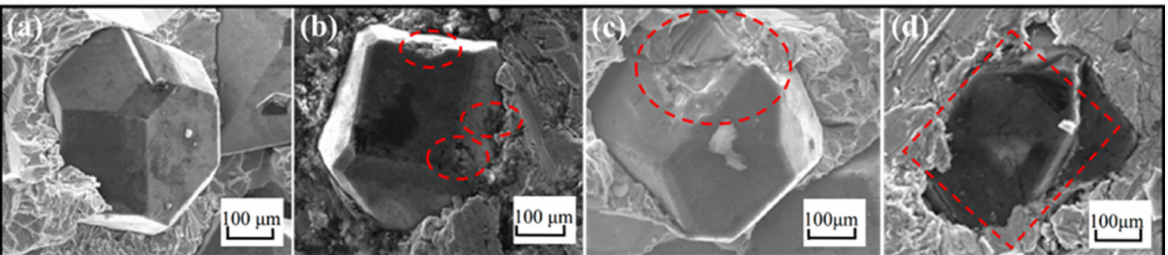
Figure 21. SEM images of wear patterns of diamond after vacuum brazing: ( a ) complete diamond particles, ( b ) small pieces broken, ( c ) large pieces broken, ( d ) flattened. Reprinted with permission from Ref. [81]. Copyright 2012,